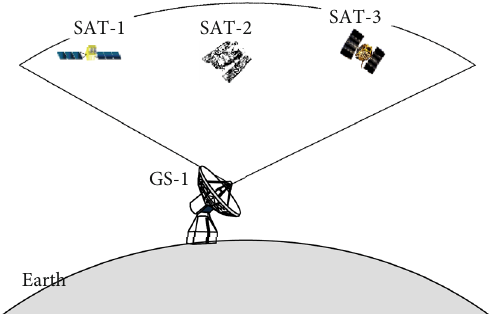
Figure 1: A con fl ict sample of three satellites for the same ground station.